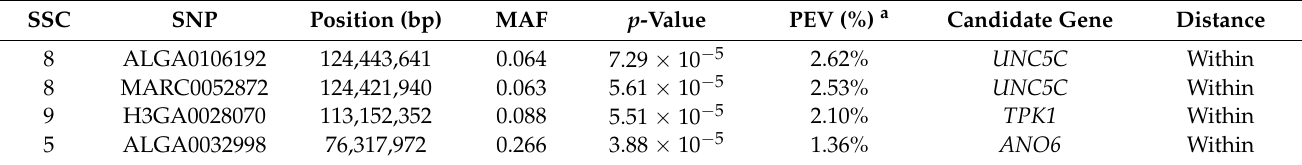
Figure 5. Venn diagram showing the distribution of SNPs in the single-trait GWASs and multi-trait GWASs, highlighting the role of pleiotropic SNPs in multiple traits. Table 4. Significant SNPs and candidate genes for Heart WT, Liver WT, Spleen WT, Lung WT, Kidney WT, and Stomach WT in multi-trait